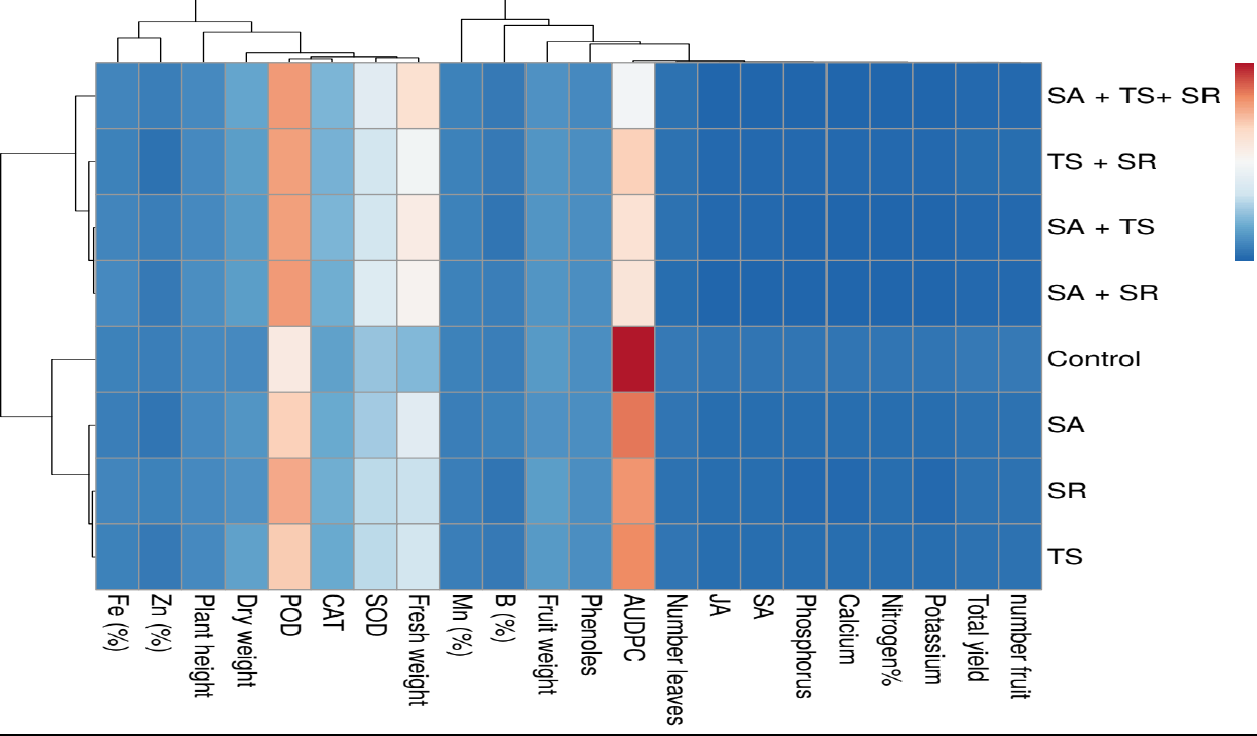
Figure 7. Heatmap of shikimic acid (SA) seed priming rates 40 ppm and foliar applications of S. rochei (SR), T. asperellum (TS), S. rochei + T. asperellum (SR + TS), and water (control) and measured parameters of squash plants. The differences in the response variables between all studied treatments are visualized in the heatmap diagram. Columns represent the individual response variables, while rows represent the treatments. Lower numerical values are colored blue, whereas higher numerical values are colored red (see the scale at the top right corner of the heatmap).